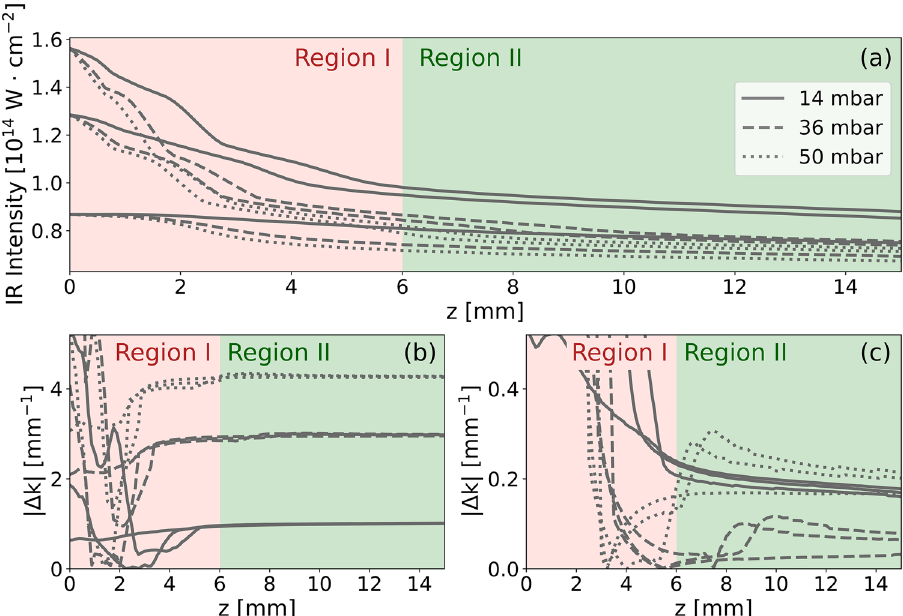
Figure 1. ( a ) Results of numerical simulations of a 30 fs pulse propagating in krypton demonstrating the stabilization of the on-axis intensity for different medium pressures and input laser intensities with emphasis on region I in light red, where intensity drops rapidly and region II in light green, where intensity stabilizes. ( b ) Evolution of phase-mismatch (cid:31) k between the 800-nm laser and the 17th harmonic order calculated for the same pulse propagation as in panel ( a ). ( c ) Phase-mismatch for the same laser pulse as in ( b ), but with the medium homogeneously pre-ionized to 8%. The medium length is set to 15